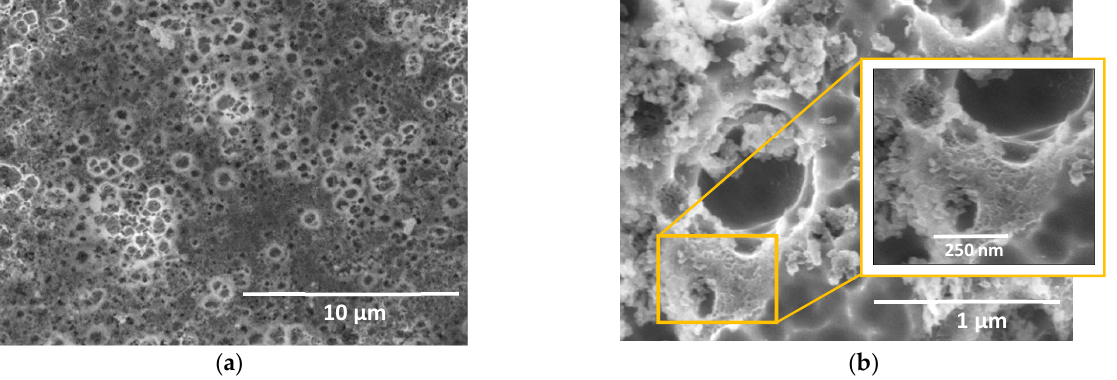
Figure 5. SEM images of the anodic layers grown in glycerol, 0.1 M Na 2 SiO 3 , and 2.5 vol% H 2 O for 15 min at 20 mA/cm 2 .